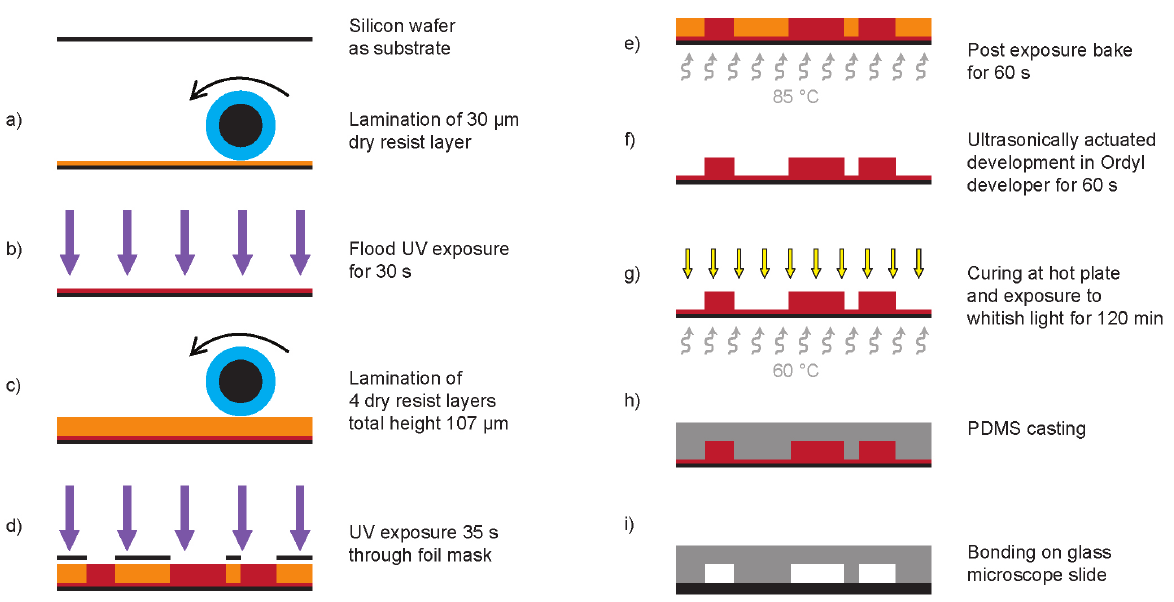
Figure 4. Fabrication process of the micro-chips; ( a ) lamination of a 30 µm thick dry resist layer onto a one-sided polished silicon wafer, ( b ) flood UV exposure of the 30 µm dry resist layer for 30 s to improve the adhesion of following layers, ( c ) consecutive lamination of four layers (one 17 µm and three 30 µm) to reach the final structure height of 107 µm, ( d ) UV exposure (35 s) through a high resolution printed foil mask (64,000 dpi) to structure the elements, ( e ) post exposure bake for 60 s at 85 ◦ C, ( f ) ultrasonically actuated development of the structures in Ordyl developer for 60 s, ( g ) curing of the master devices at 60 ◦ C for 120 min under exposure to whitish light, ( h ) PDMS casting, and ( i ) final plasma activated bonding of the PDMS devices onto glass microscope